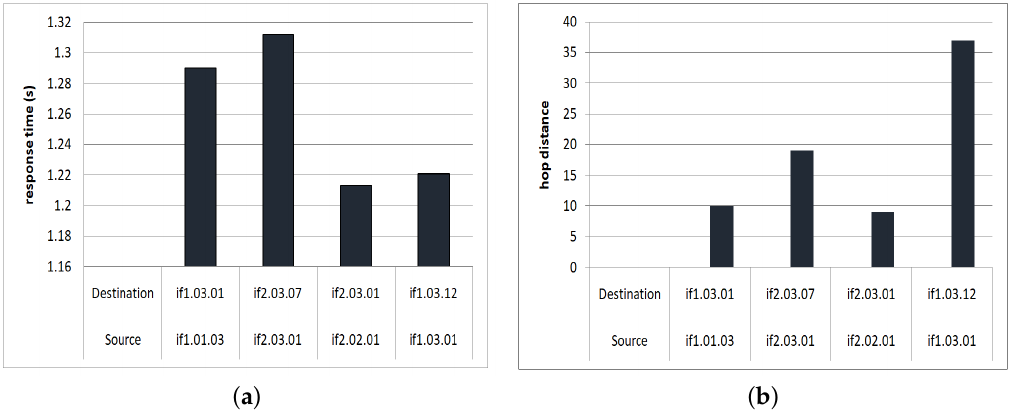
Figure 15. Performance of routing between two cells in four cases in the same building and different floors. ( a ) Response time performance; ( b ) the distance of hops in the same buildings and different floors.